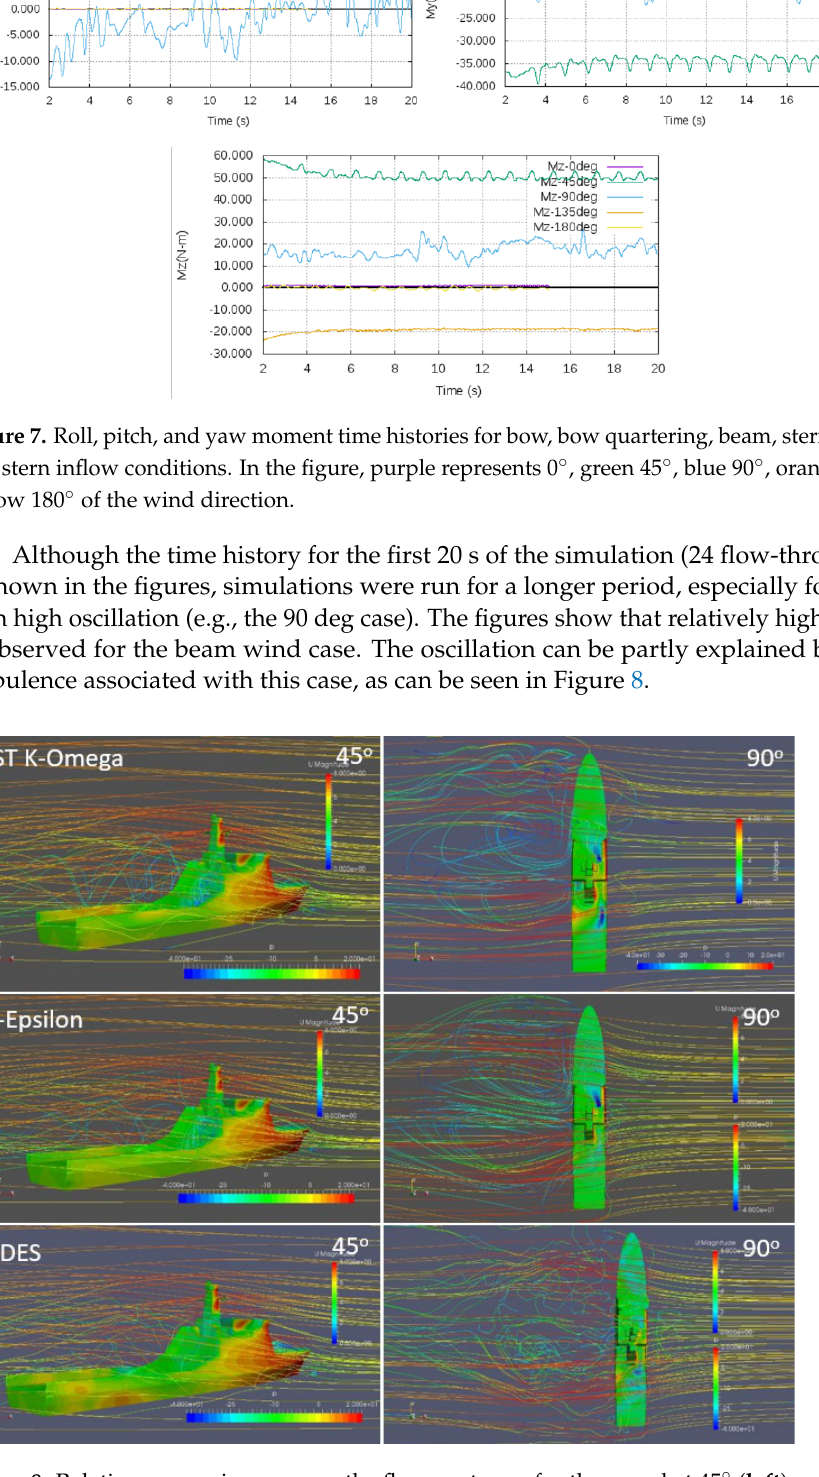
Figure 8. Relative comparison among the flow contours, for the vessel at 45° ( left ) and 90° ( right ) drift angle, generated using SST K-Omega, K-Epsilon, and DDES turbulence modelling, respectively (velocity scale: 0 to 8; Pr. scale : −40 to 20; model scale simulations).